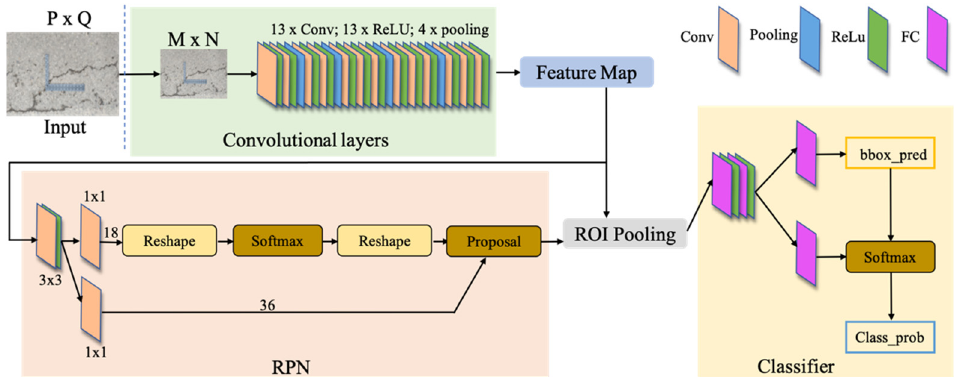
Figure 10. Pavement crack detection network structure.